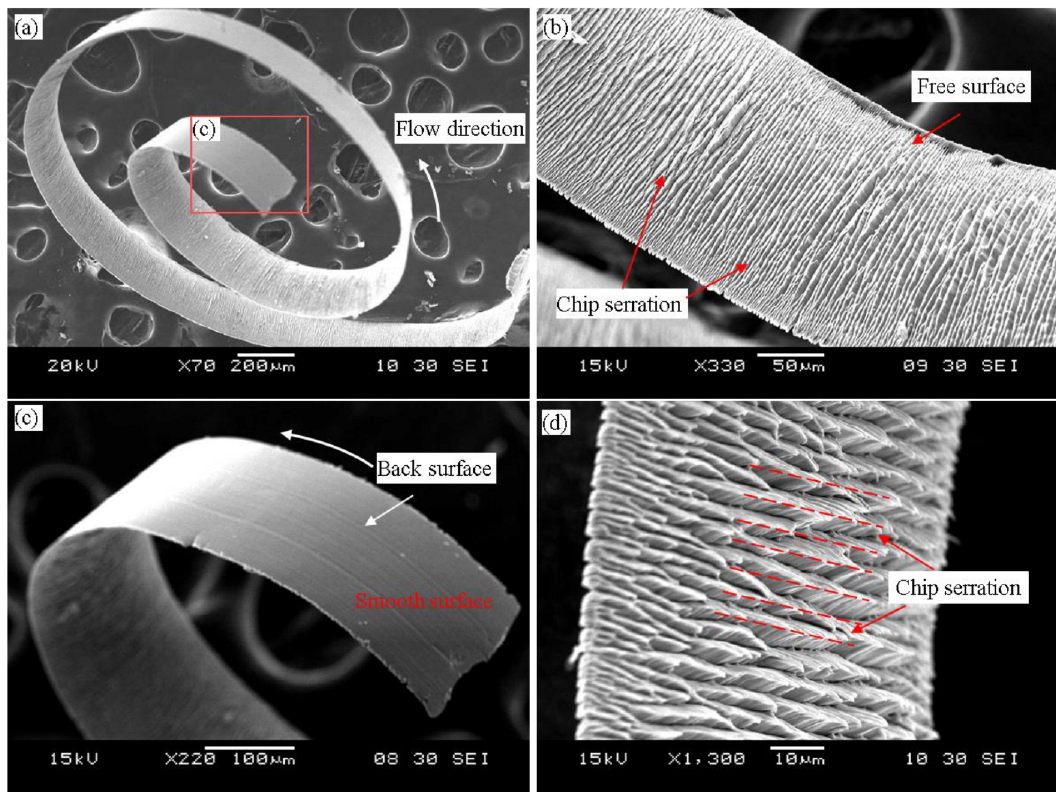
Figure 9. Chip morphology of micro-grooving experiments for the speed corresponding to 60 mm/min, and the depth of cut was 10 µ m. ( a ) overall chip morphology; ( b , d ) free surface of the chip; ( c ) back surface of the chip.